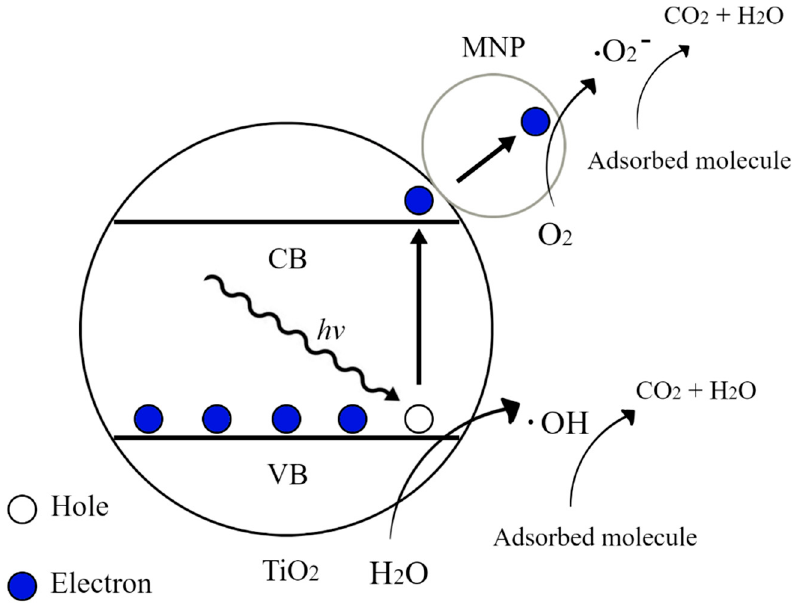
Figure 3. Phototatalytic mechanism of a TiO 2 /MNP substrate to degrade adsorbed molecules.